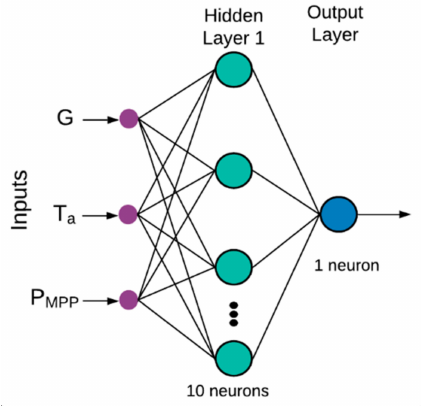
Figure 10. System 1 and 2 MLP structure. Table 6. System 1 and 2 MLP training